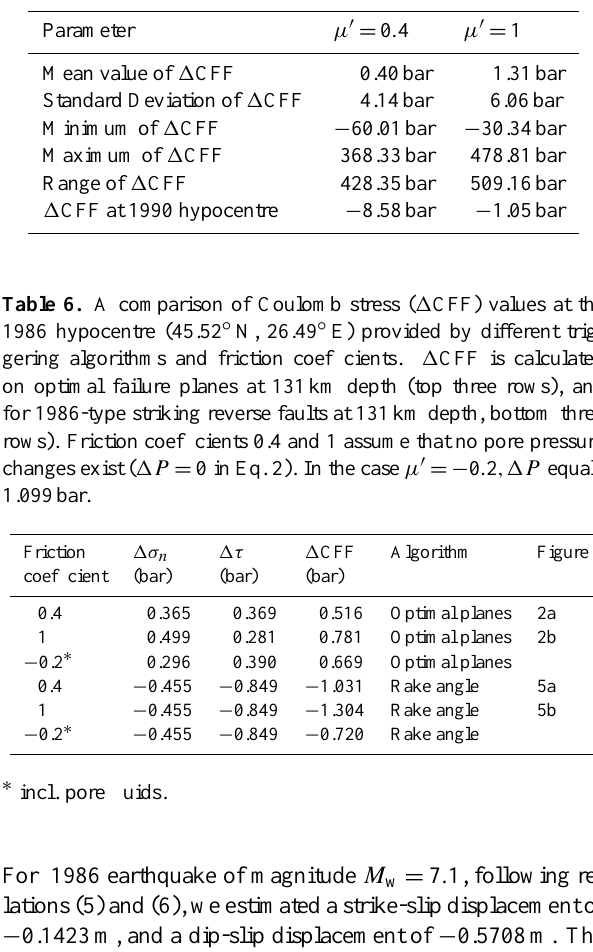
Table 5. Parameters of statistical analysis of combined 1 CFF at depth 89km, hypocentre area of 1990 event (40400values) assum- ing azimuth of tectonic stress at N307 ◦ E. We can see that by in- creasing the coefficient of friction, 1 CFF is increased.